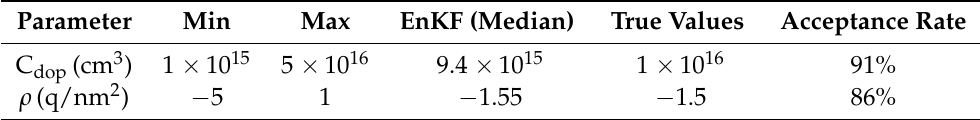
Table 1. The computational features and the results of the Bayesian